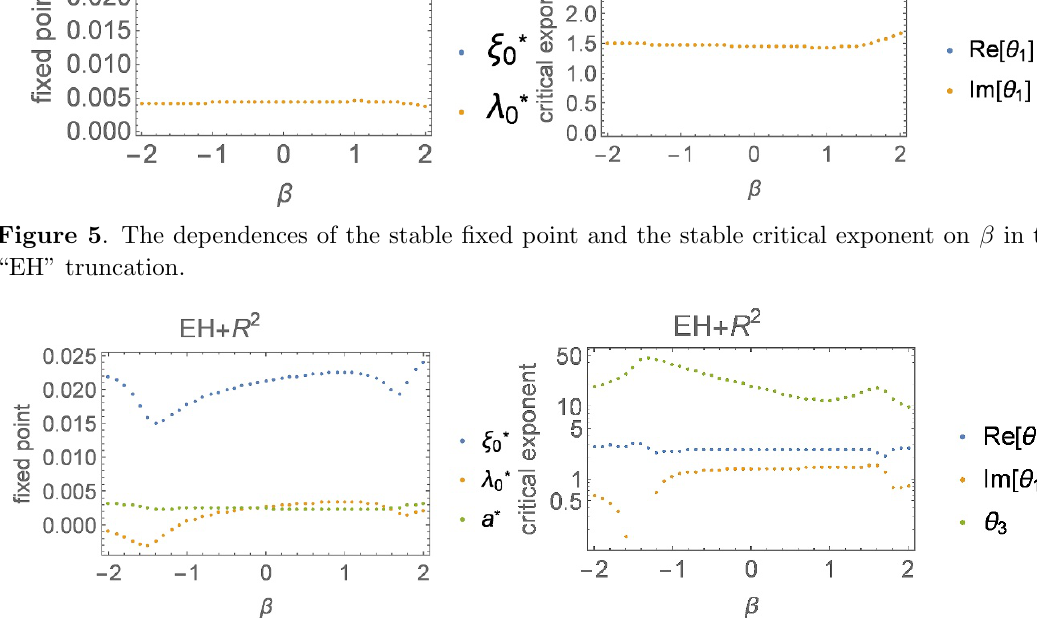
Figure 6 . The dependences of the stable (cid:12)xed point and the stable critical exponent on (cid:12) in the \EH + R 2 "